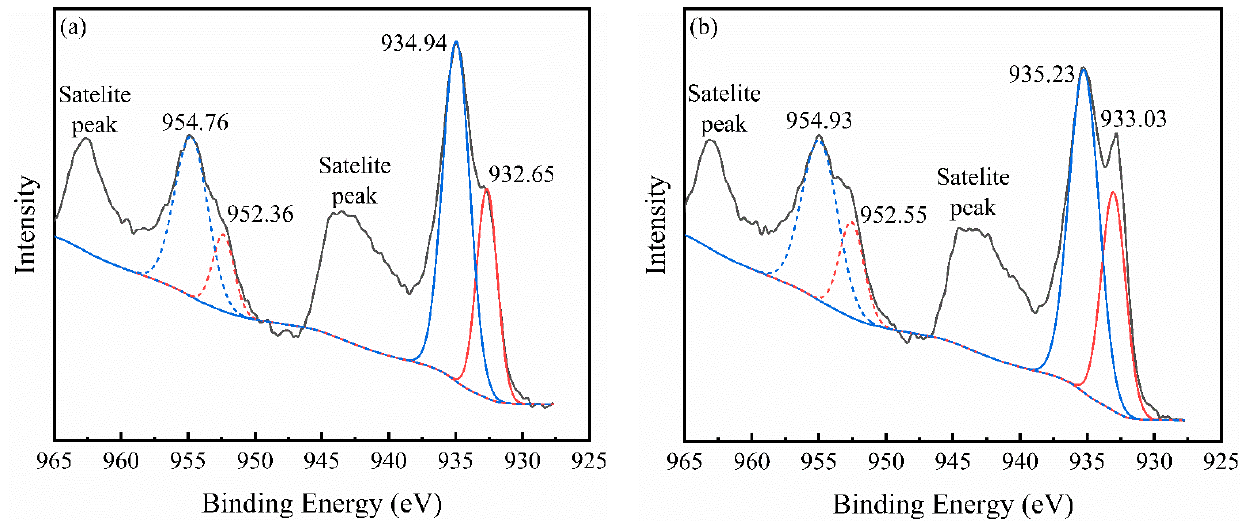
Figure 9. Cu 2p XPS spectra of malachite surfaces as follows: ( a ) treated with Na 2 S, ( b ) treated with (NH 4 ) 2 S, Na 2 S = 6 × 10 − 2 mol/L, (NH 4 ) 2 S = 6 × 10 − 2